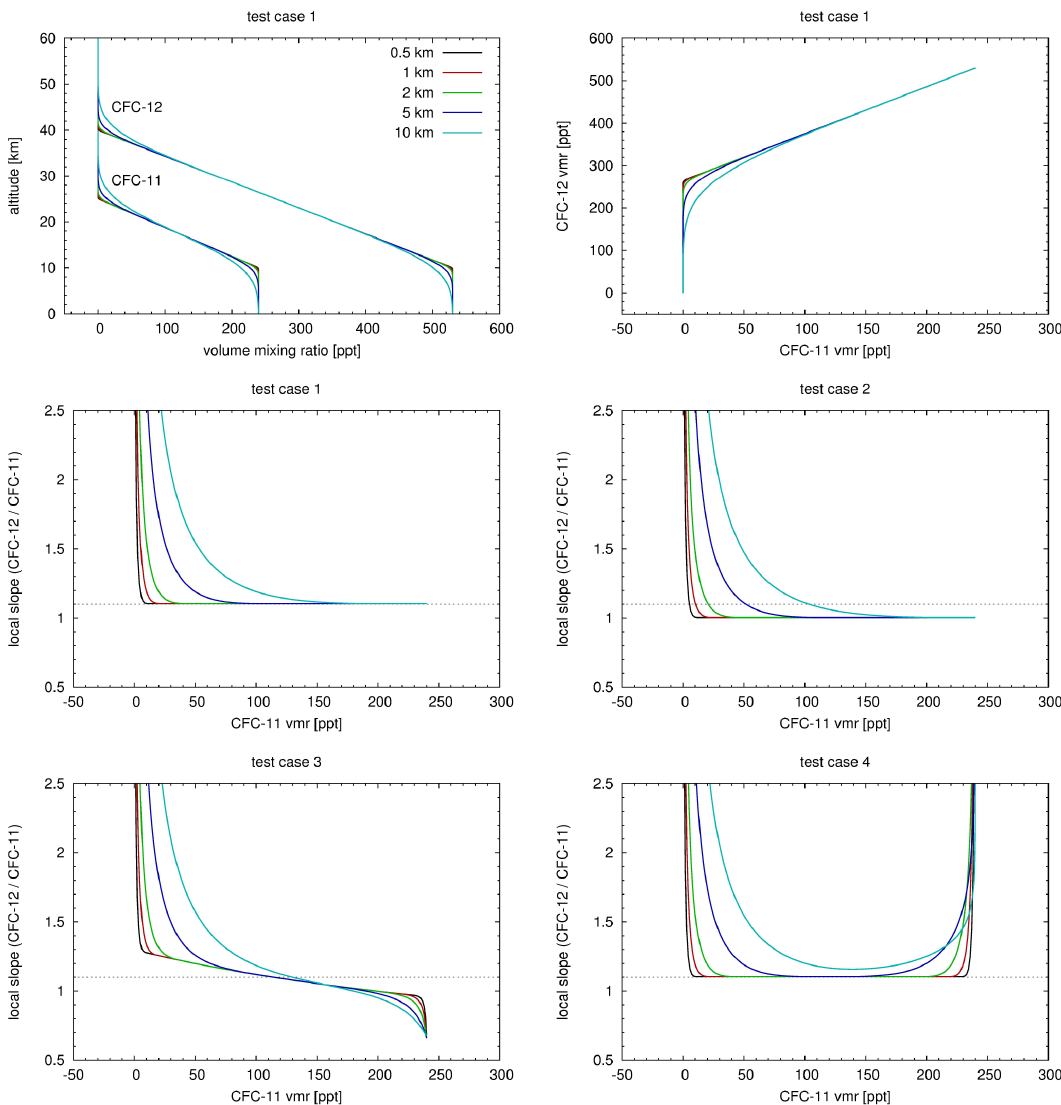
Figure A1. Idealized CFC profiles (top, left), tracer–tracer correlations (top, right), and local tracer–tracer slopes for different test cases (other). Colored curves refer to different vertical smoothing; see plot legend for full width at half maximum of the Gaussian shape function used to convolve the profiles. In test case 1 no errors are imposed on the CFC profiles. In test case 2 the CFC-11 profile has a constant 10% bias. For test case 3 we imposed an altitude-dependent error of 1%km − 1 on the CFC-11 profile. In test case 4 the CFC-11 profile is shifted upward by